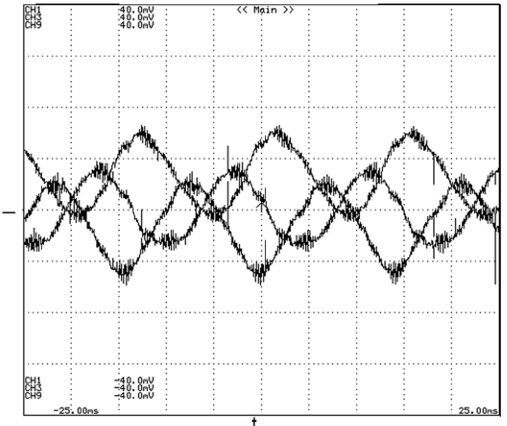
Figure 6. DC current offset in 2.2 kW induction machine phase currents in field-weakening region at no load due to faulty dead time compensation [8].